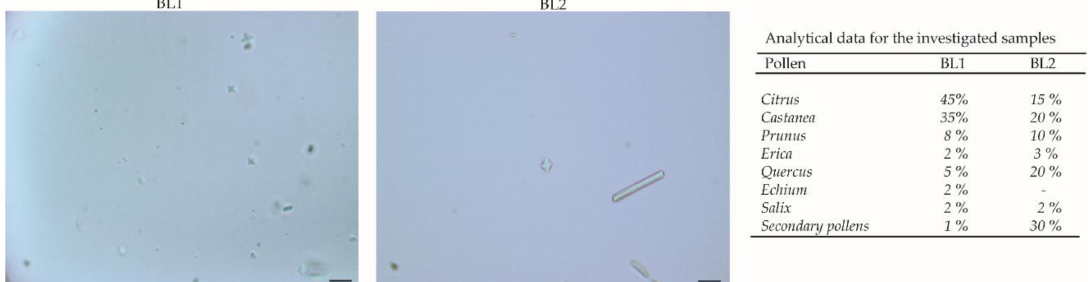
Figure 1. Melissopalynological analysis of multifloral honeys performed with an Olympus BX41 microscope; the images were taken with CSV1.14 software (RolandD Cyber Produksi, Hoogvliet Rotterdam, The Netherlands) using a CAM XC-30 for image acquisition. A minimum of 100 pollen grains were evaluated in each slide. Six slides were scored for each sample by two independent